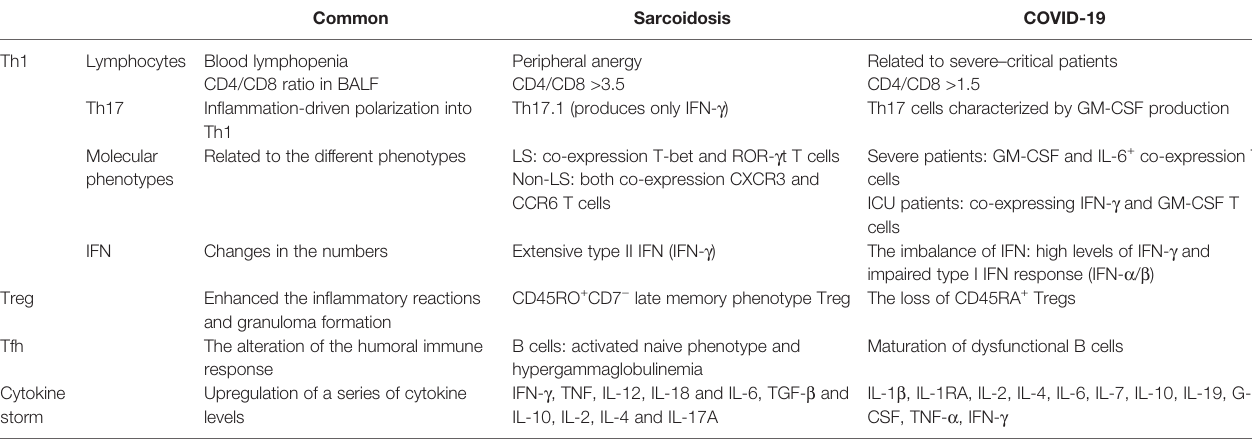
TABLE 1 | The characteristics of sarcoidosis and COVID-19 on the immune system.